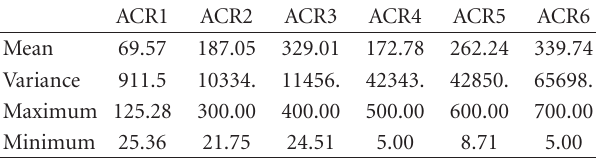
Figure 2: BL Pos versus μ BL Table 3: The values of the ACR (cells/sec).